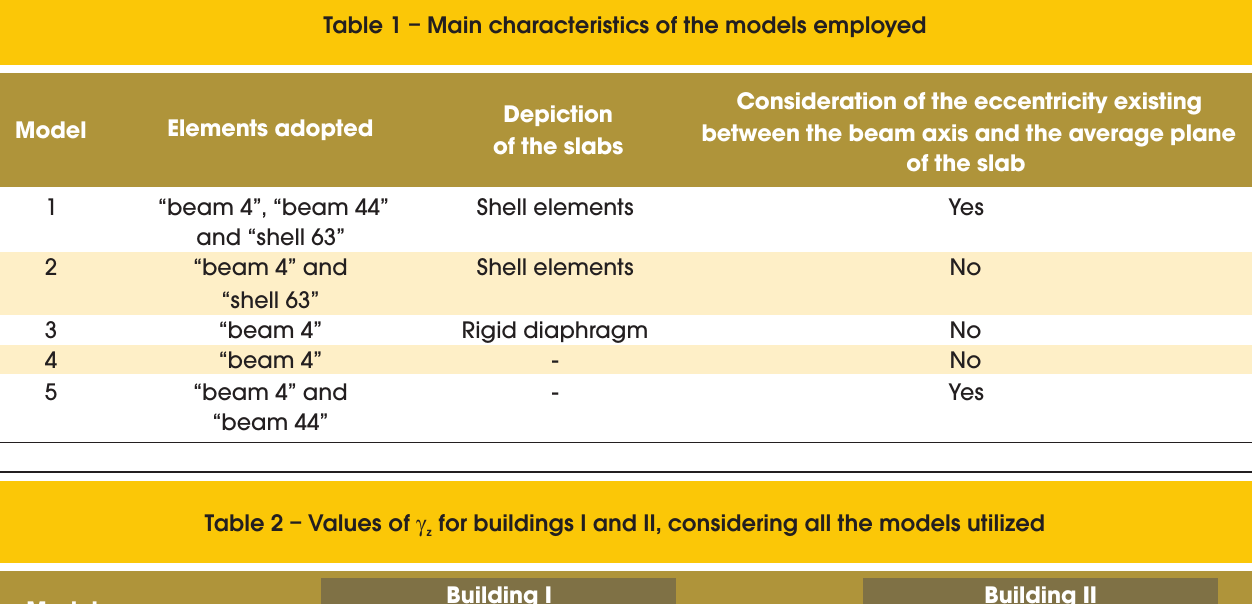
BEAM AXIS = AVERAGE PLAN OF